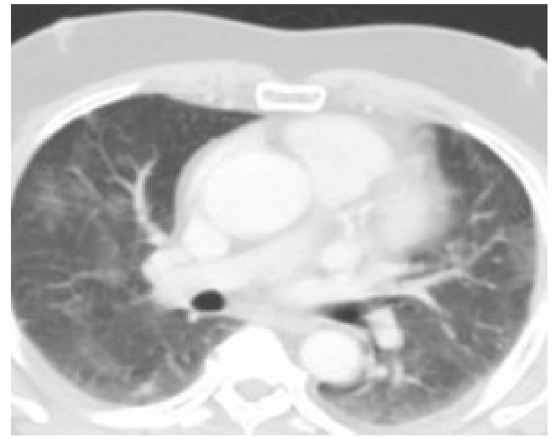
Fig. 4 CT chest: bilateral multifocal patchy areas of ground glassing associated with reticulations and fibroelastic bands, probably post-COVID-19 pulmonary fibrosis (sequelae of post-COVID-19 viral infection)